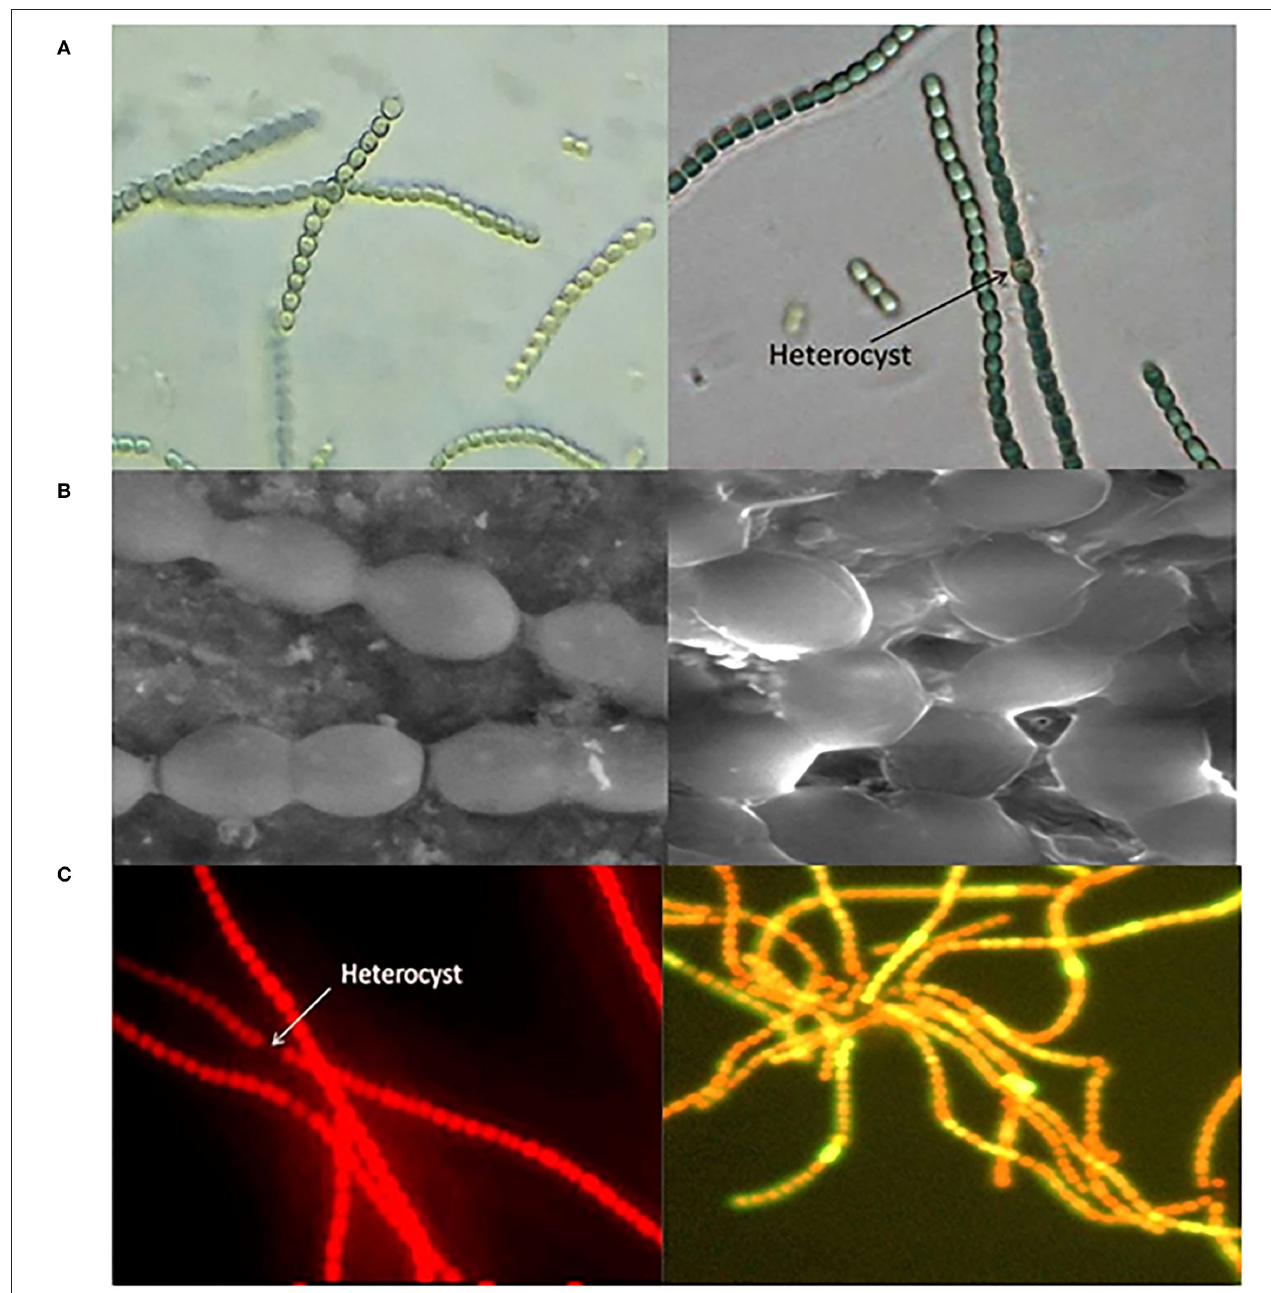
FIGURE 1 | Mic of Cyanobacterium Anabaena sp. (A) Phase contrast microscopic images, (B) scanning electron microscopic (SEM) images, and (C) fluorescence microscopic image showing auto-fluorescent pigments.